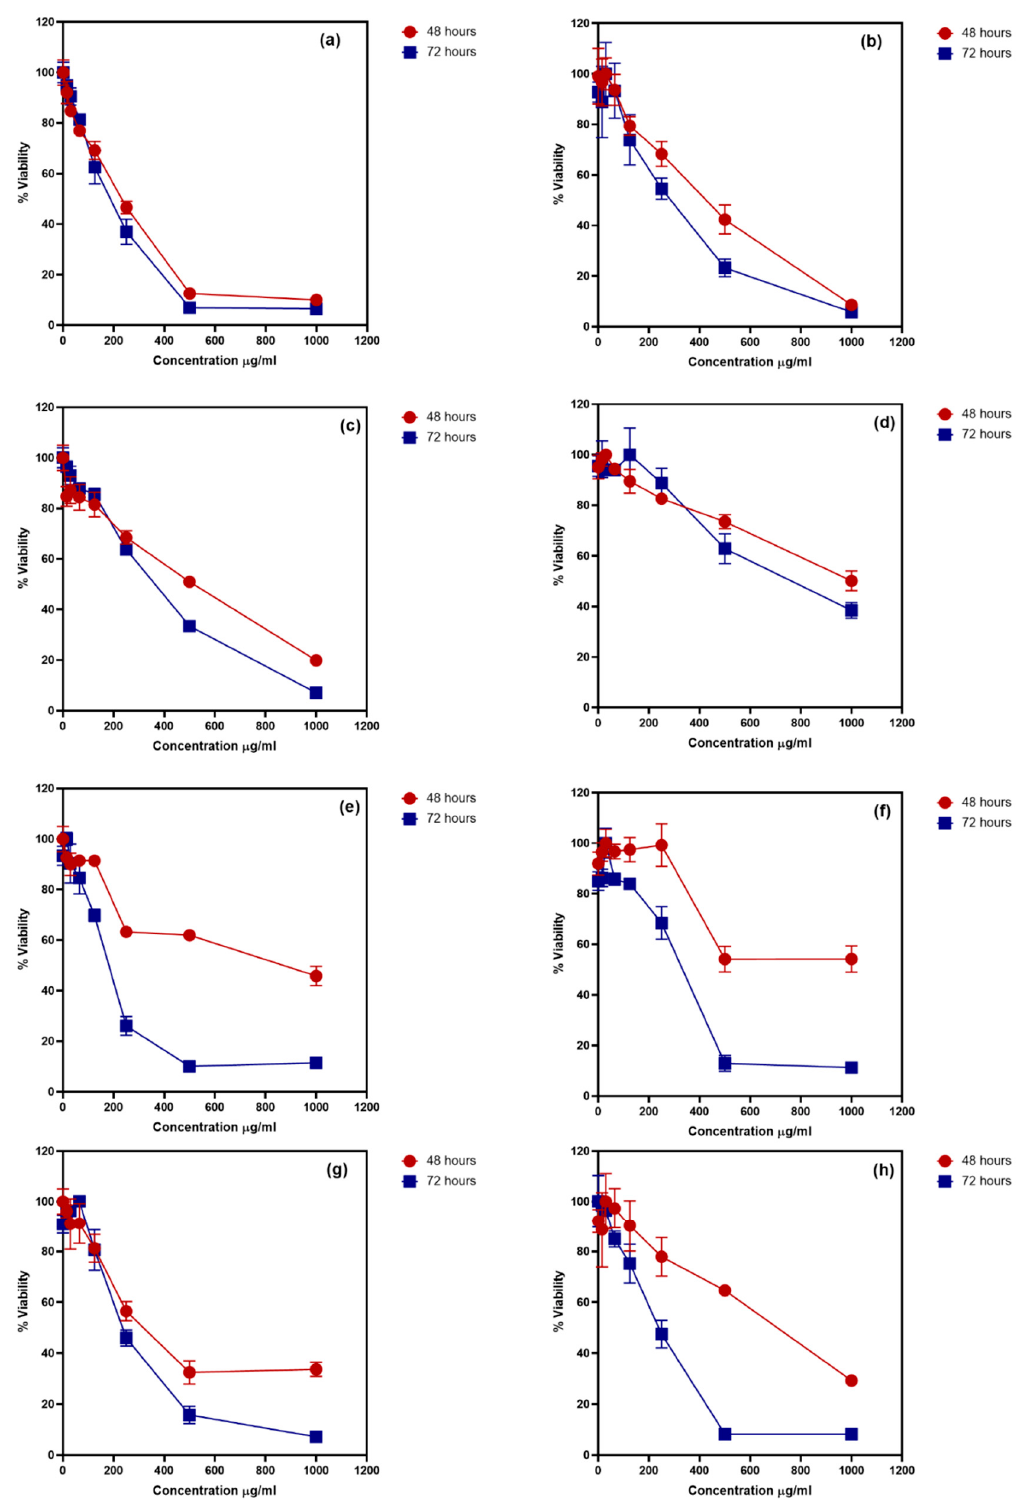
Figure 1. Graphical representation of cell viability percentage with M. peregrina tuber extracts on MCF-7 and Caco-2 cells with 48 and 72 h incubation: ( a )—Hexane extract in MCF-7; ( b )—hexane extract in Caco-2 ( c )—chloroform extract in MCF-7; ( d )—chloroform extract in Caco-2; ( e )—acetone extract in MCF-7; ( f )—acetone extract in Caco-2 ( g )—methanol extract in MCF-7 and ( h )—methanol extract in Caco-2. Values are expressed as mean ± SD of three experiments ( p -value relative to control group: p < 0.05).